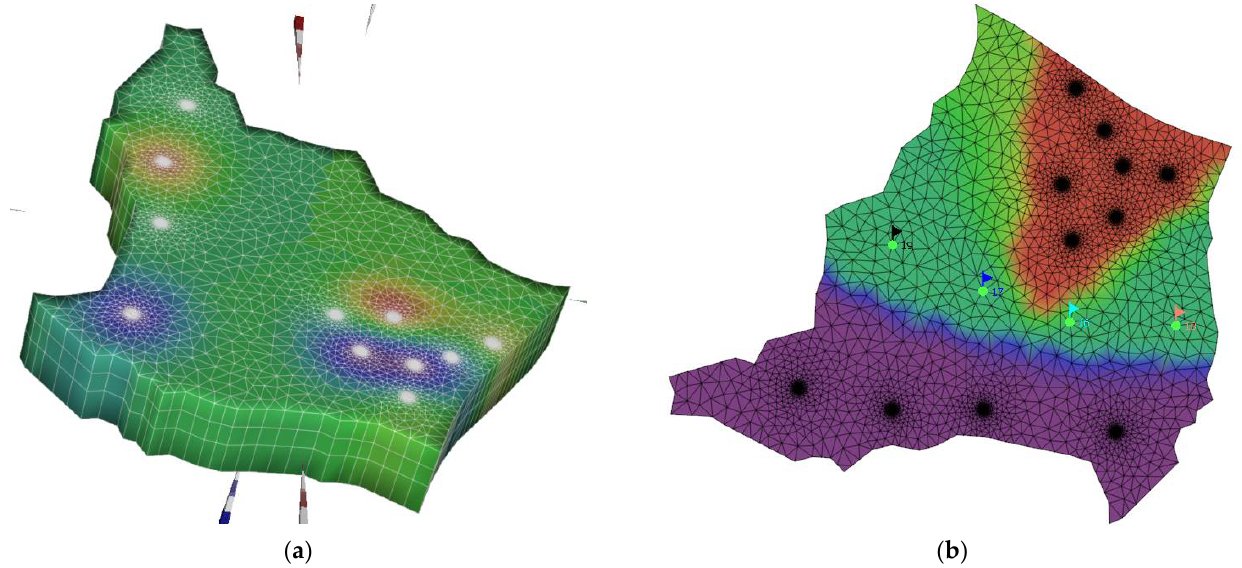
Figure 1. High enthalpy reservoir model: ( a ) distributed model finite element grid; ( b ) initial temperature of the reservoir floor distribution honoring the magmatic intrusion effect.